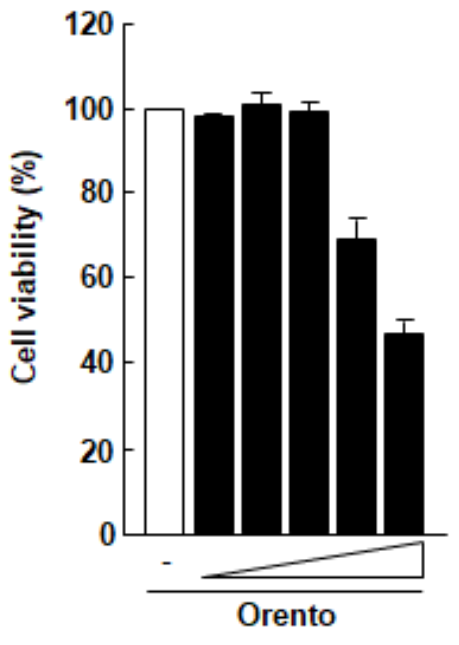
Figure 1. Effect of orento on the proliferation of Saos-2 cells. Figure 1. E ff ect of orento on the proliferation of Saos-2